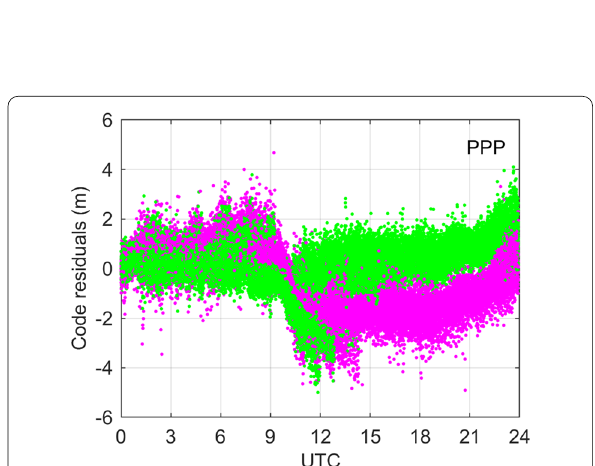
Fig. 5 P1 (magenta dots) and P2 (green dots) residuals of code observations at station MTDN using the original PPP model